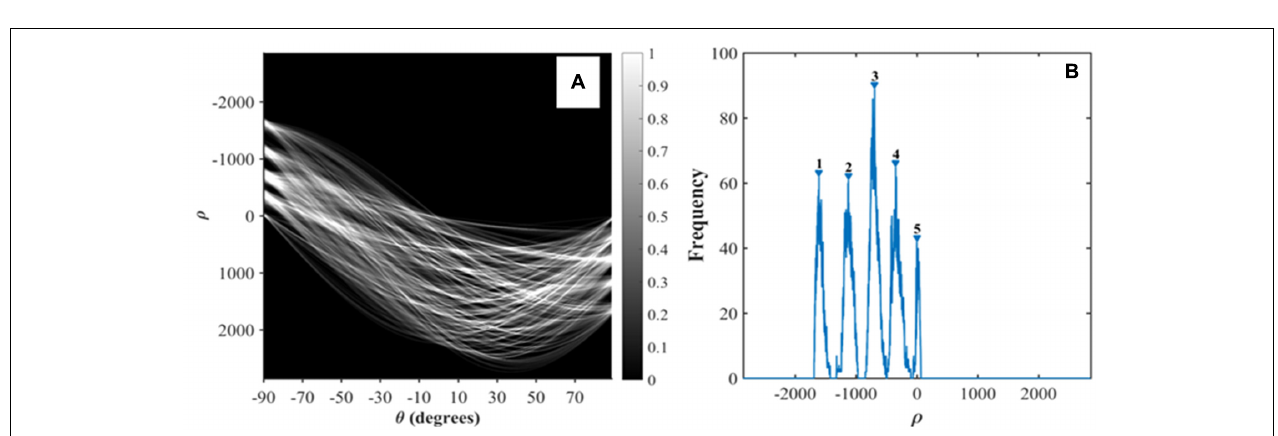
FIGURE 2 | The methodology involving image processing feature extraction. (a) Original image. (b) Binary image. (c) Image of a chessboard to derive the transformation matrix. (d) Calibrated image. (e) Detecting rows in the image, corresponding to red dashed lines. (f) Labeling rows with different colors. (g) Correcting row orientation to be horizontal.